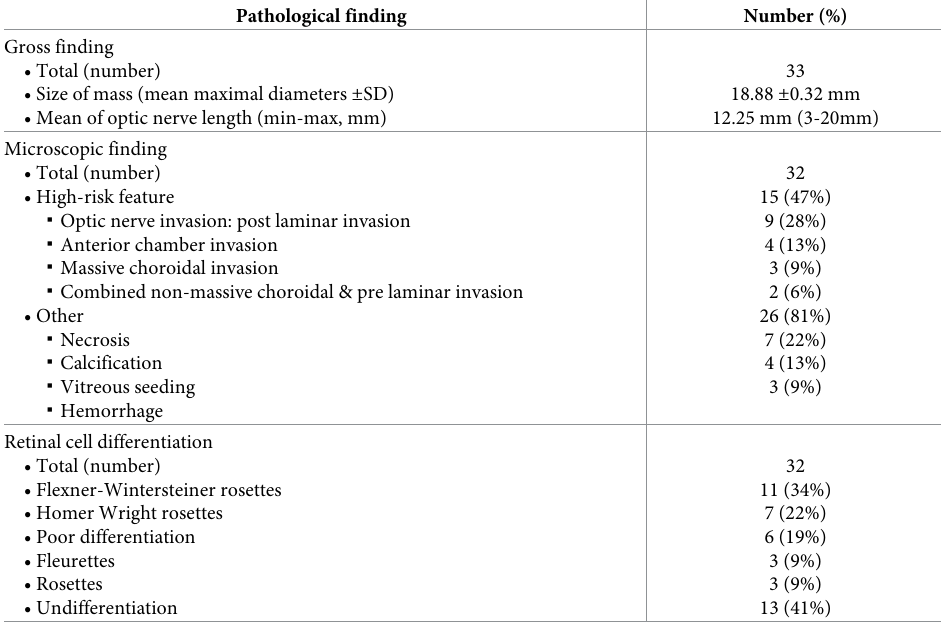
Table 4. Pathological finding in primary enucleated retinoblastoma